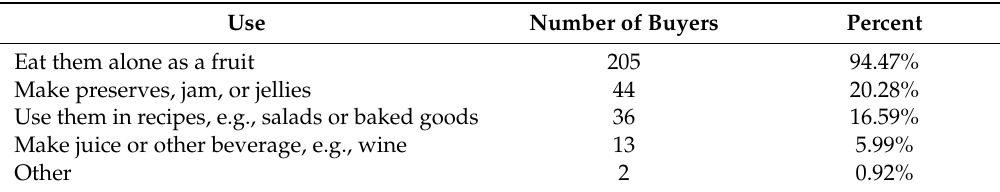
Table 4. Buyers’ uses of fresh muscadine grapes.